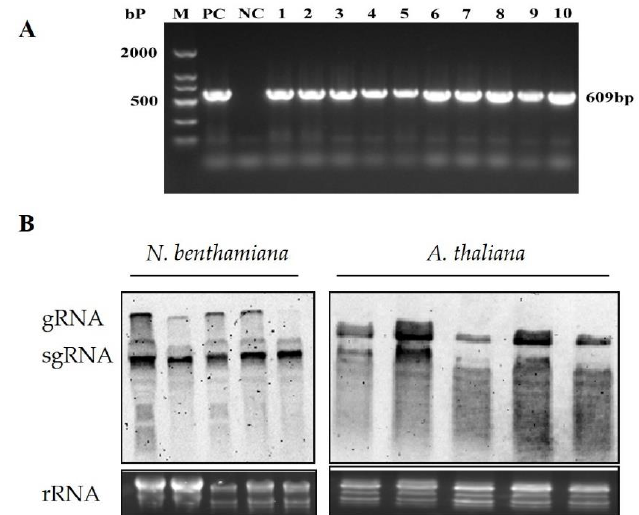
Figure 4. Detection results of BrYV in inoculated N. benthamiana and A. thaliana at 14 dpi. ( A ) RT-PCR for the detection of infection by BrYV-HY in the upper leaves of N. benthamiana (1 – 5) and A. thaliana (6 – 10) at 2 weeks post-inoculation with the primers BrYV-CP-F/BrYV-CP-R. PC, positive control; NC, negative control. ( B ) Northern blot analysis of BrYV accumulation in inoculated N. benthamiana and A. thaliana at 14 dpi using a DIG-labeled specific probe targeting BrYV CP coding sequences. Five independent plants were used to extract the total RNAs. The rRNAs below demonstrate the equal loading of the total RNAs.